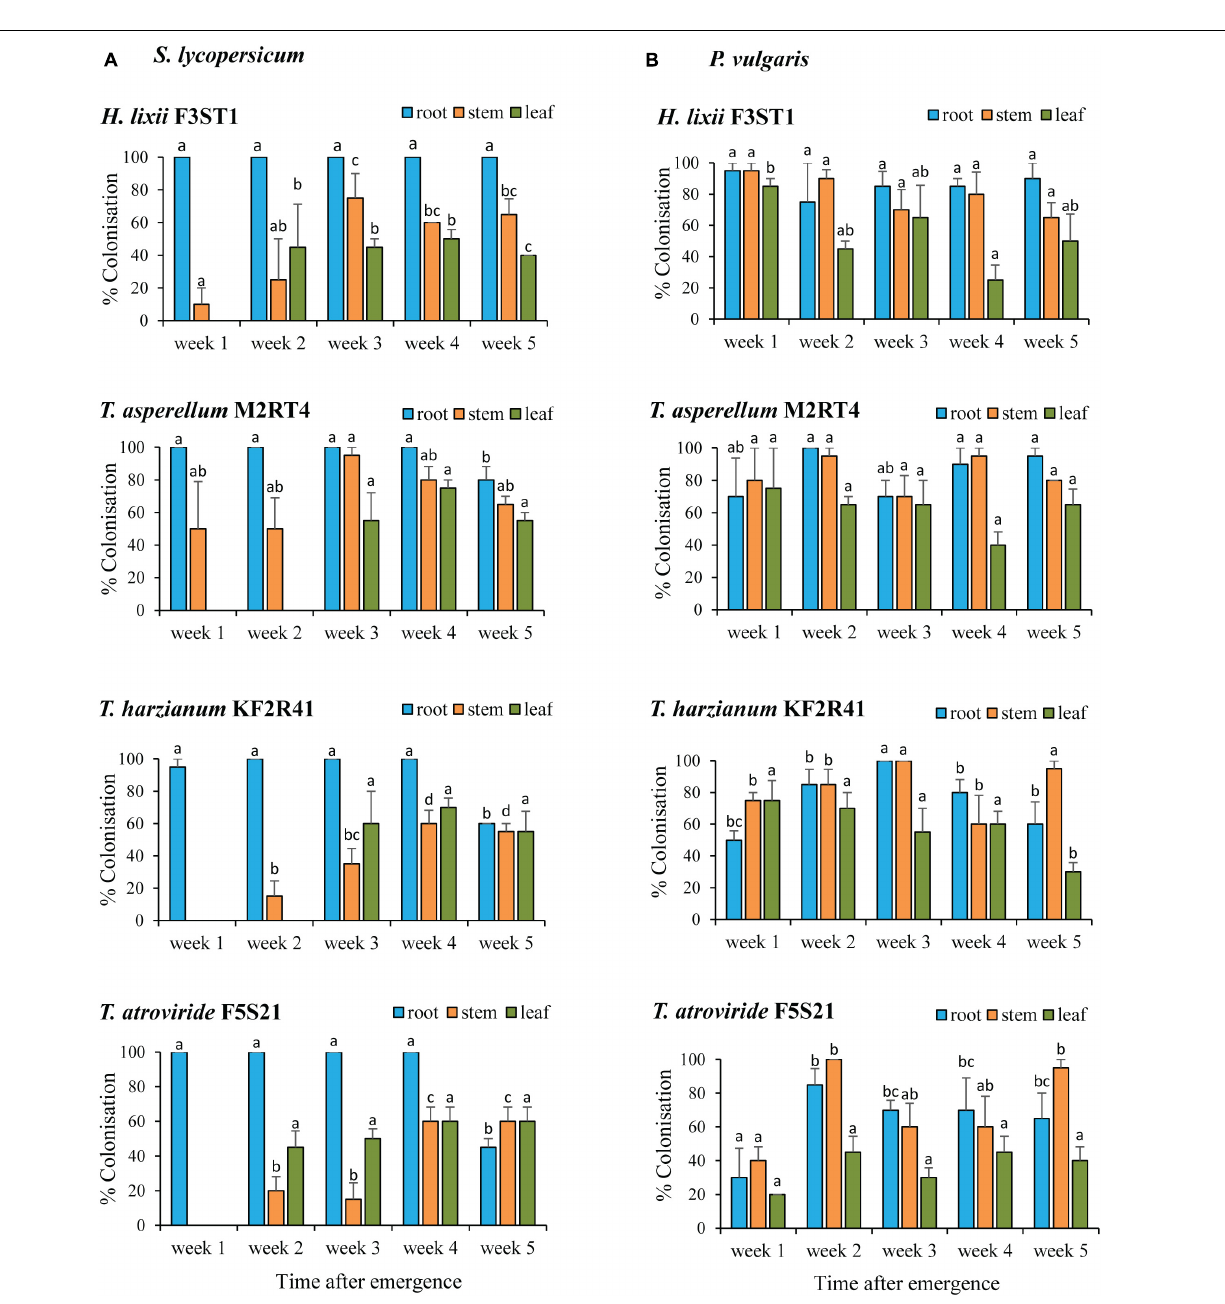
FIGURE 2 | Endophytic persistence of H. lixii F3ST1, T. asperellum M2RT4, T. atroviride F5S21, and T. harzianum KF2R41 in host plants S. lycopersicum (A) and P. vulgaris (B) 5 weeks post-germination. Error bars represent the SE ( ± SE) of the means at 95% CI (Tukey’s HSD test, P ≤ 0.05). Bars indicated by the same letters for the same plant part (root, stem, leaf) across weeks are not significantly